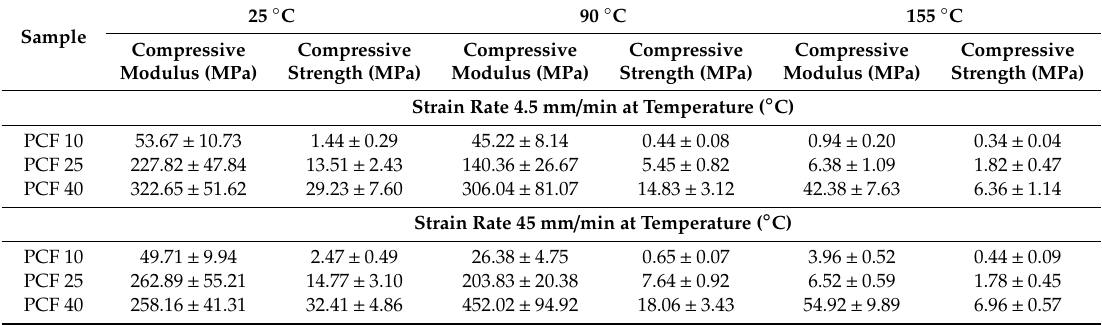
Table 5. Summary of the compressive test results: strain rates 4.5 mm / min and 45 mm / min. 25 ◦ Sample